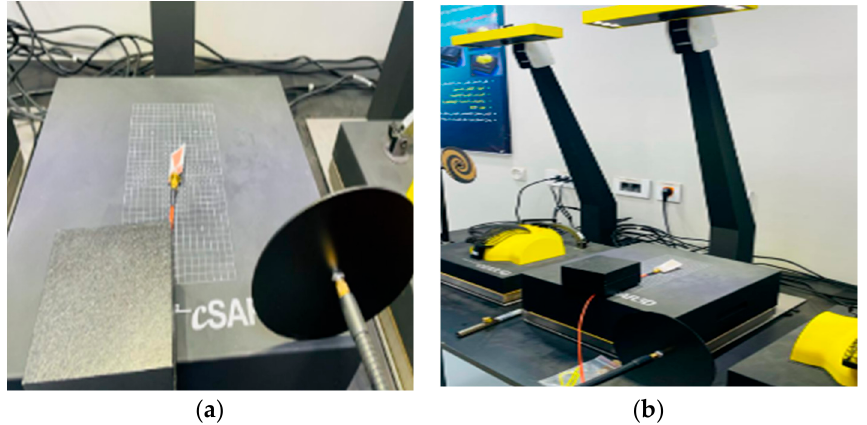
Figure 6. SAR measurements of the proposed antenna-based sensor: ( a ) flexible Roger substrate and ( b ) conductive textile.